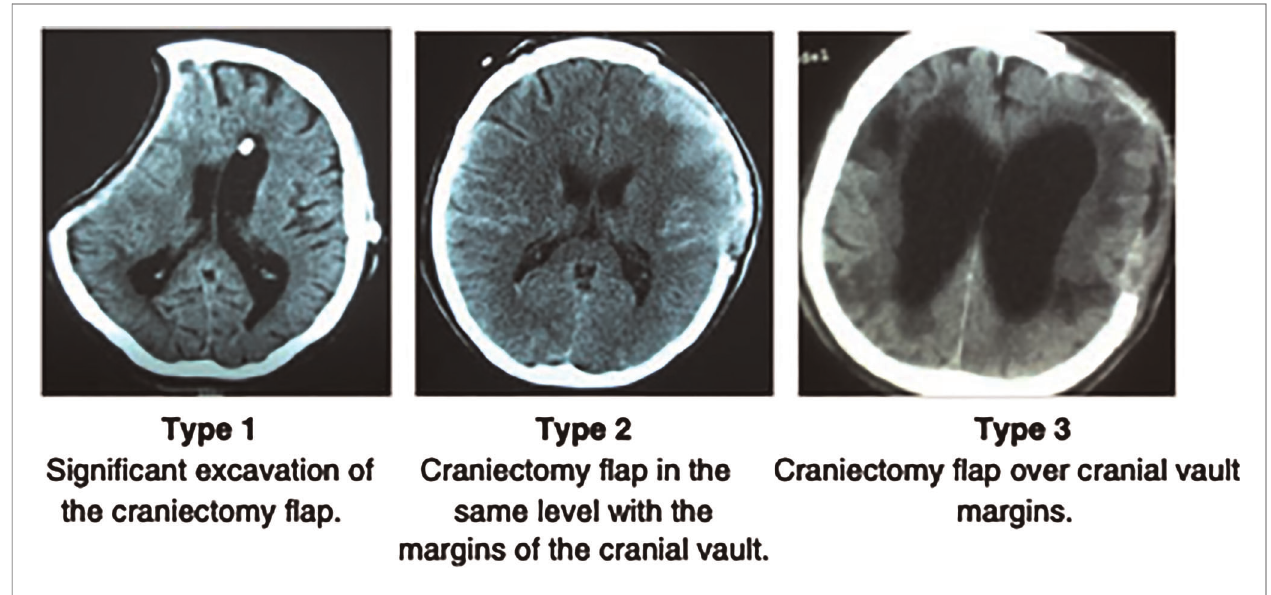
FIGURE 1 | Archavlis et al